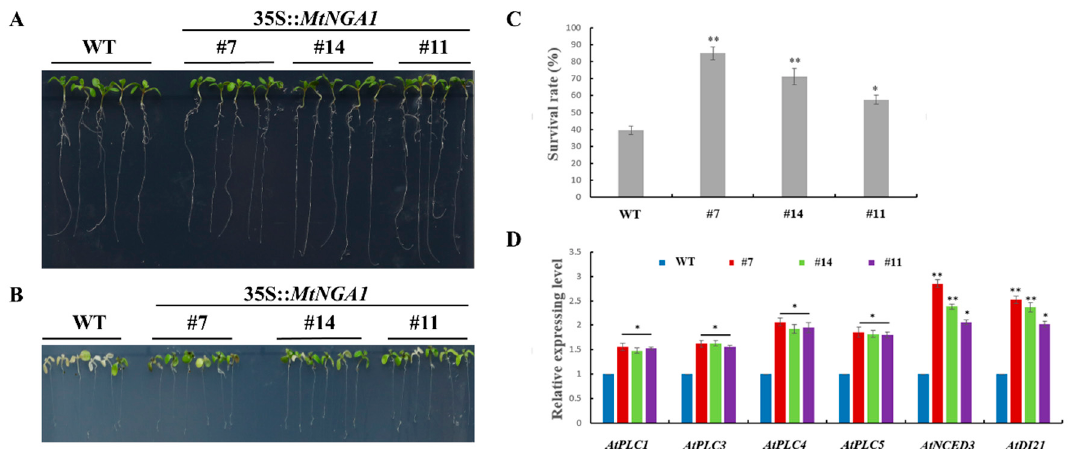
Figure 8. Responses of WT and transgenic plants to NaCl treatment. ( A ) Five-day-old seedlings of transgenic lines and WT plants were planted on 1 / 2 MS medium without NaCl and grown for 3 days. ( B ) Five-day-old seedlings of transgenic lines and WT plants were planted on 1 / 2 MS medium with 200 mM NaCl and grown for 3 days. ( C ) The survival rates of transgenic lines and WT plants were measured 3 days after 200 mM NaCl treatment ( n = 30). ( D ) Expression analysis of ATPLC1 , ATPLC3 , ATPLC4 , ATPLC5 , AtNCED3 and AtDI21 in the transgenic lines and WT plants ( n = 3), PLC , phosphatidylinositol-specific phospholipase C . NCED3, NINE-CIS-EPOXYCAROTENOID DIOXYGENASE 3. DI21, drought-induced 21 ; The values are the means ± SDs. * indicates significant di ff erences of the means at p < 0.05 between transgenic lines and WT plants. ** indicates significant di ff erences of the means at p < 0.01 between transgenic lines and WT plants.